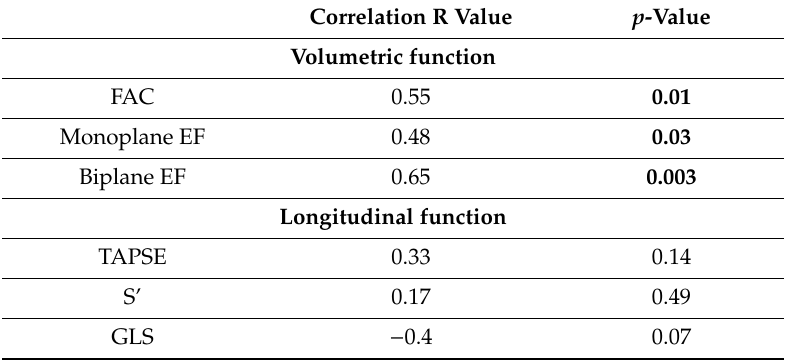
Table 2. Correlation of cardiac magnetic resonance imaging derived systemic ventricle ejection fraction with 2D echocardiographic parameters of longitudinal and volumetric systolic